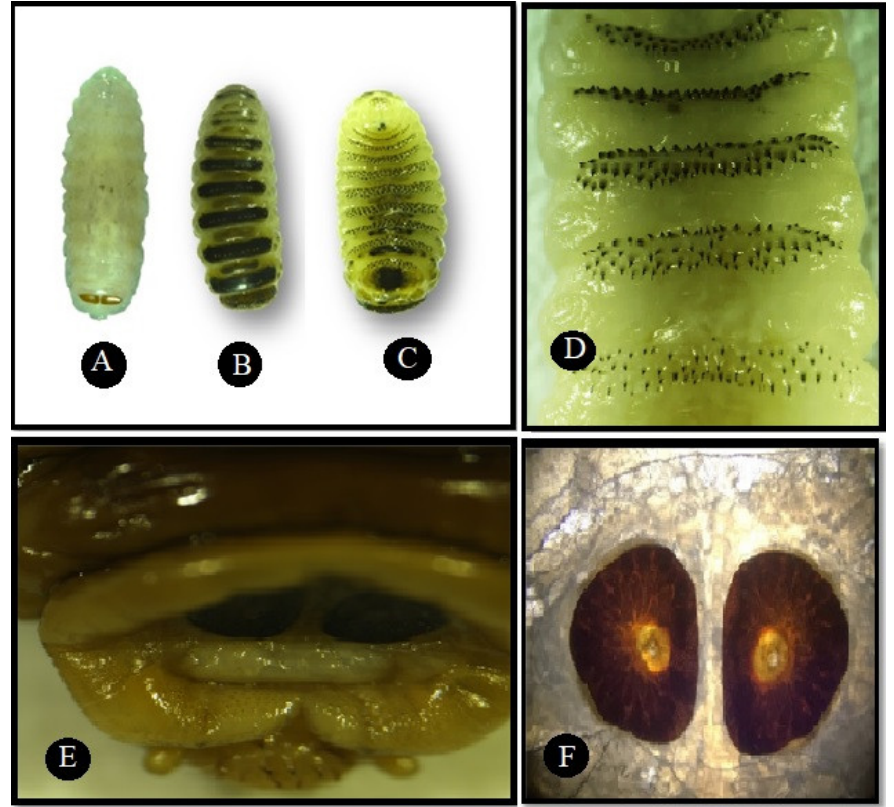
Figure 4. Third instar larva (L3). ( A ) Yellow color; ( B ) dorsal view shows broad transverse blackish bands; ( C ) ventral view shows spines on segments; ( D ) magnified view of the spines on the ventral segments; ( E ) postanal bulge shows fewer spines; ( F ) posterior spiracle is in a D-shape with central button but no distinct suture.